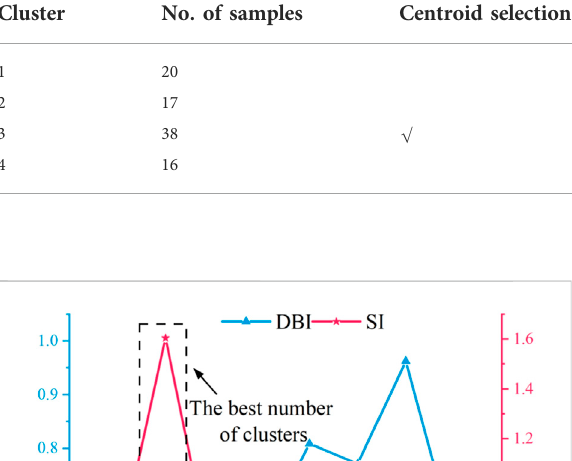
TABLE 3 The details of the centroid selected for a user in the load dataset. Cluster